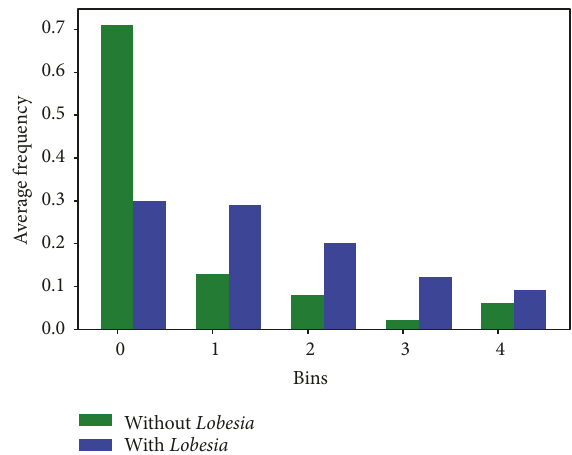
Figure 13: Gradient modulus descriptor Lobesia versus other